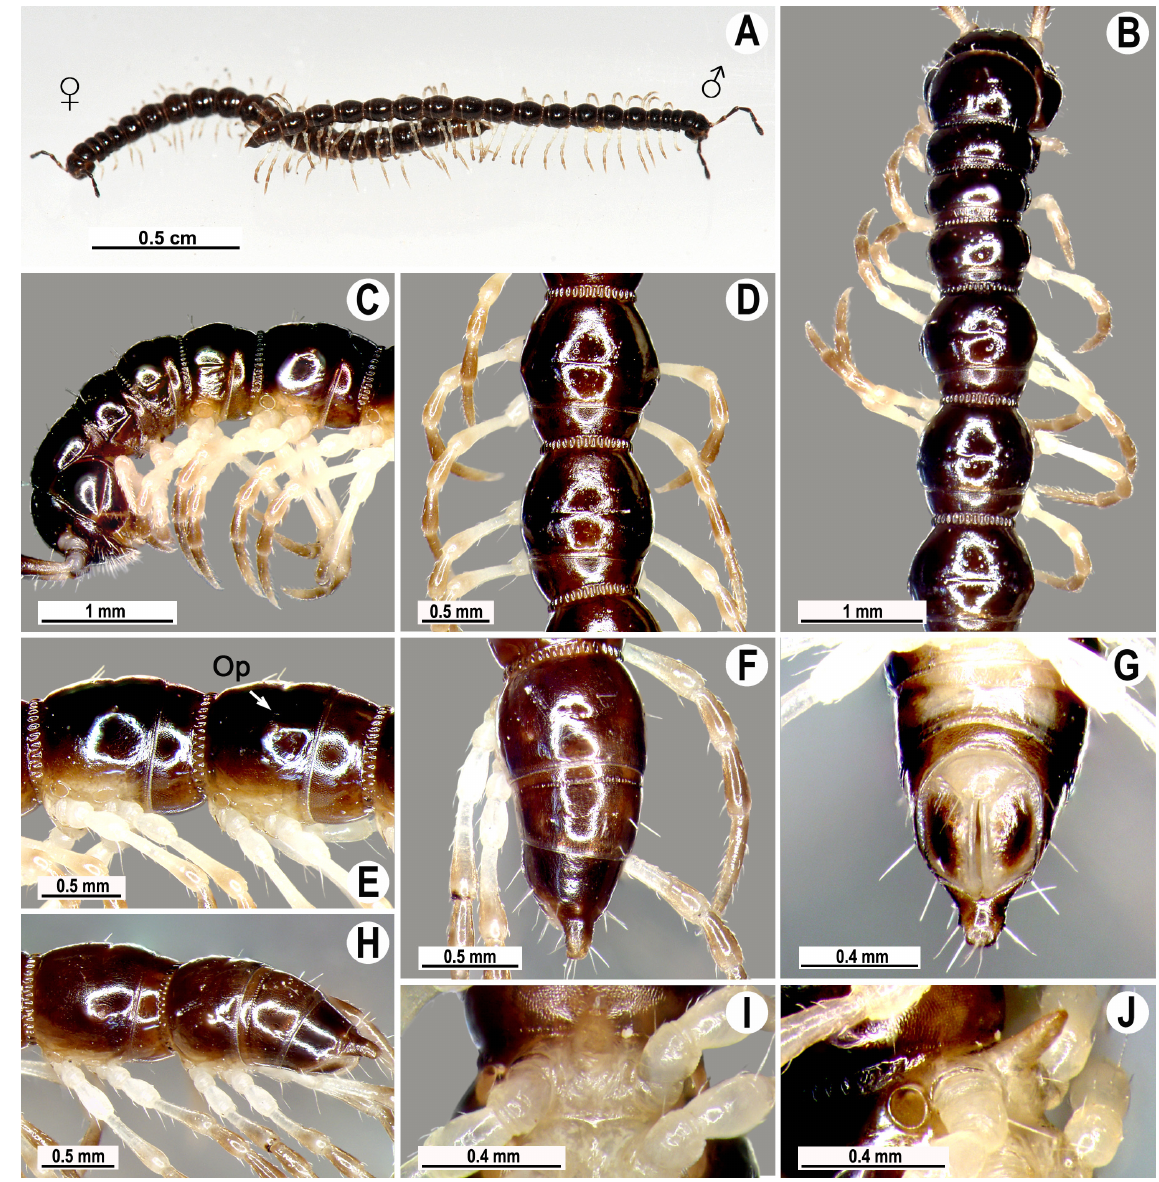
Fig. 7. Tylopus moniliformis sp. nov., holotype, ♂ ( B–J ), paratypes, ♂, ♀ ( A ). A . habitus, live coloration. B–C . anterior part of body, dorsal and lateral views, respectively. D–E . Segments 10 and 11, dorsal and lateral views, respectively. F–H . Posterior part of body, subdorsal, ventral and sublateral views, respectively. I–J . Sternal cones between coxae 4, subcaudal and sublateral views, respectively. abbreviations are explained in the